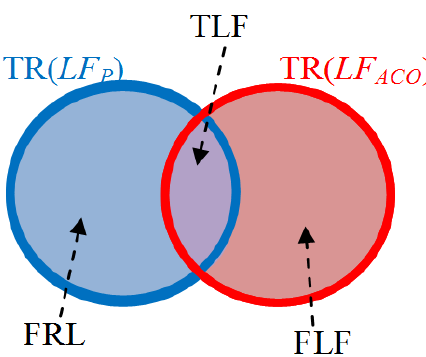
Figure 14. The relationship of parameters: false lobe fissure ( FLF ), true lobe fissure ( TLF ), and false real lobe fissure ( FRLF